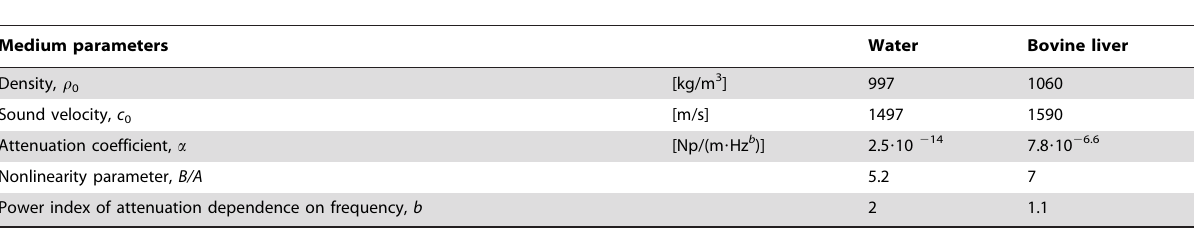
Table 2. The acoustic parameters of media of propagation at 25 u C temperature.